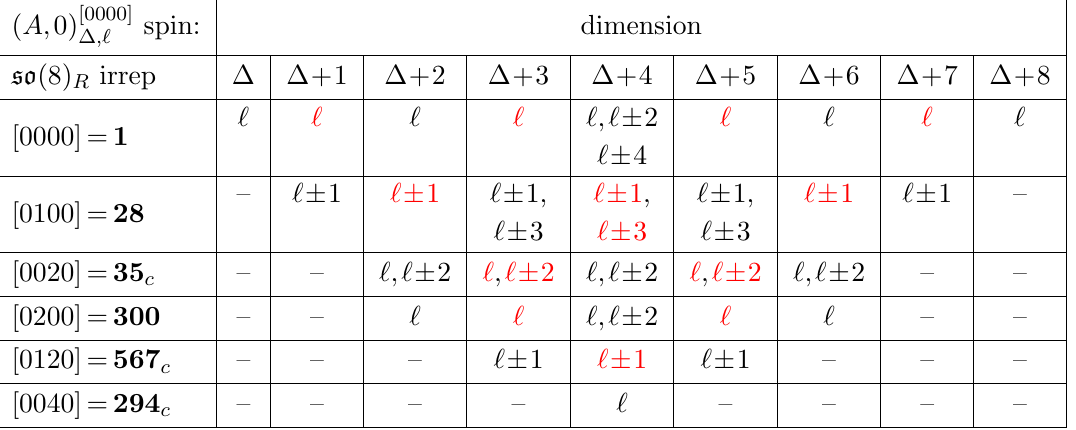
Table 29 . All possible conformal primaries in S 2 (cid:2) S 2 and S 3 (cid:2) S 3 corresponding to the ( A; 0) [0000] superconformal multiplet.